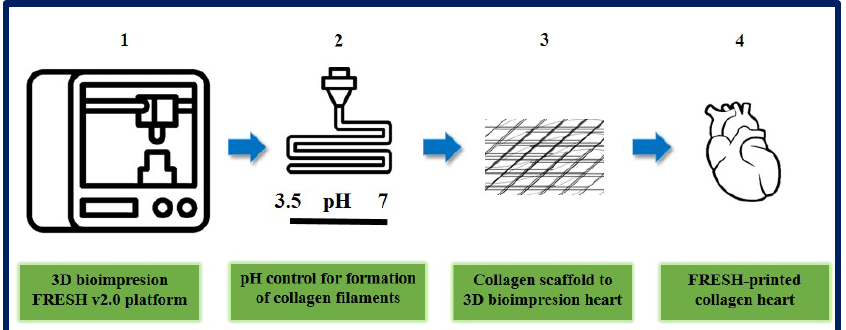
Figure 21. Organ-scale FRESH v2.0 3D bioprinting. (1) 3D bioprinting of collagen using FRESH v2.0 in high resolution. (2) pH control for rapid neutralization causing gelation to collagen filament formation process. (3) Single filaments of collagen obtained to this system were smooth with 20 to 200 nm diameter. (4) In the first instance, the ventricle was printed with a central section of cardiac cells, internal and external collagen shell, and a collagen-only section. Then Tri-leaflet heart valve 3D model at adult human scale was printed with the same system. Finally, a FRESH v2.0 collagen heart was printed at a neonatal scale. Bibliography consulted [189].